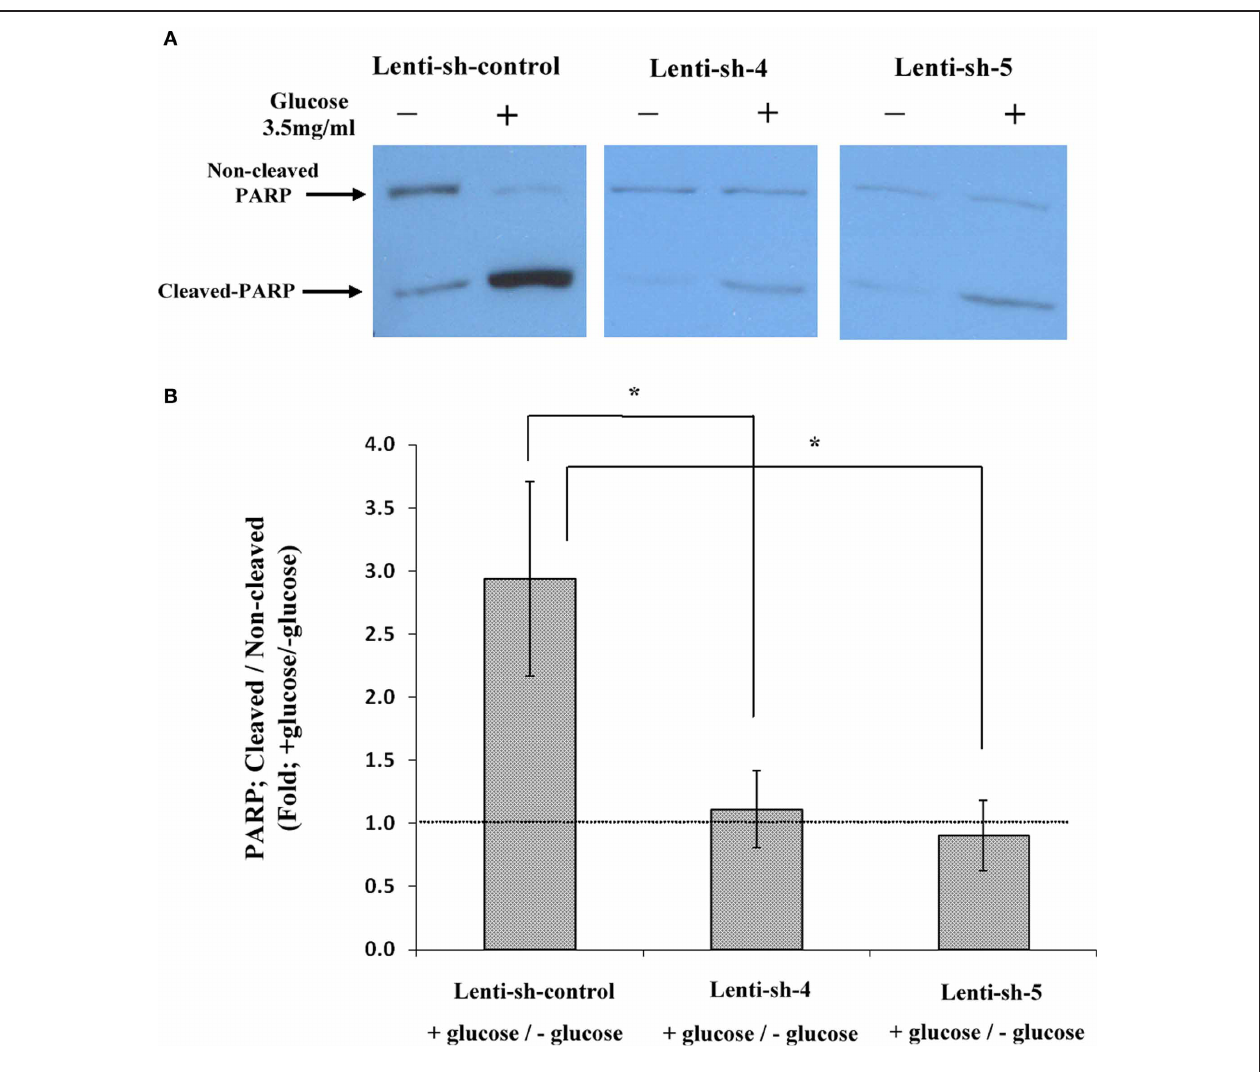
Methods. Five independent western experiments were conducted; one is shown in (A) . Densitometry values were calculated for cleaved to non-cleaved ratios, and then calculated as fold of cells incubated under starvation medium (containing 1% FBS and 1mg/ml glucose) and plotted in histograms as shown in (B) . Values are mean ± SEM, ( N = 5). ∗ p = 0 .